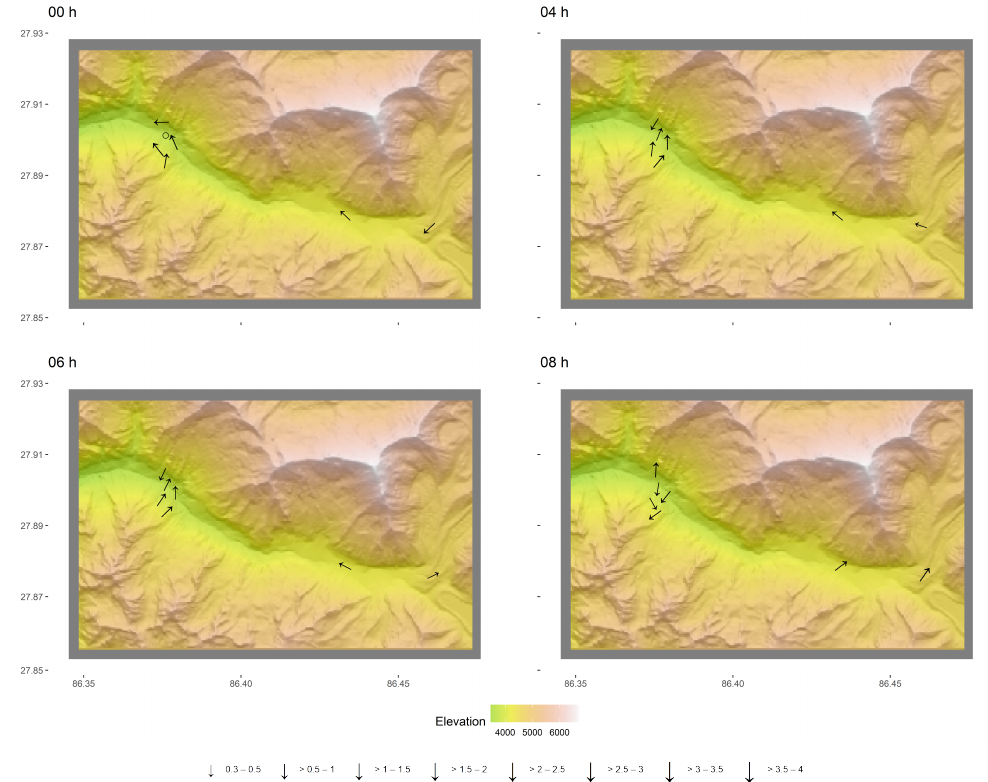
Figure 7. Diurnal forming of the winds in the Rolwaling Valley on 22 November 2017. Sub-figures showing the mean hourly wind speeds of the first hour of the day (00:00–01:00) in the top-left. The hour between 04:00 and 05:00 at the top-right, and the hours following 06:00 and 08:00 in the bottom row left and right respectively. Arrows indicate the wind direction at the stations, with the wind speed shown by the size of the arrow. Calm hours and hours with less than 0.3 m s − 1 are indicated by